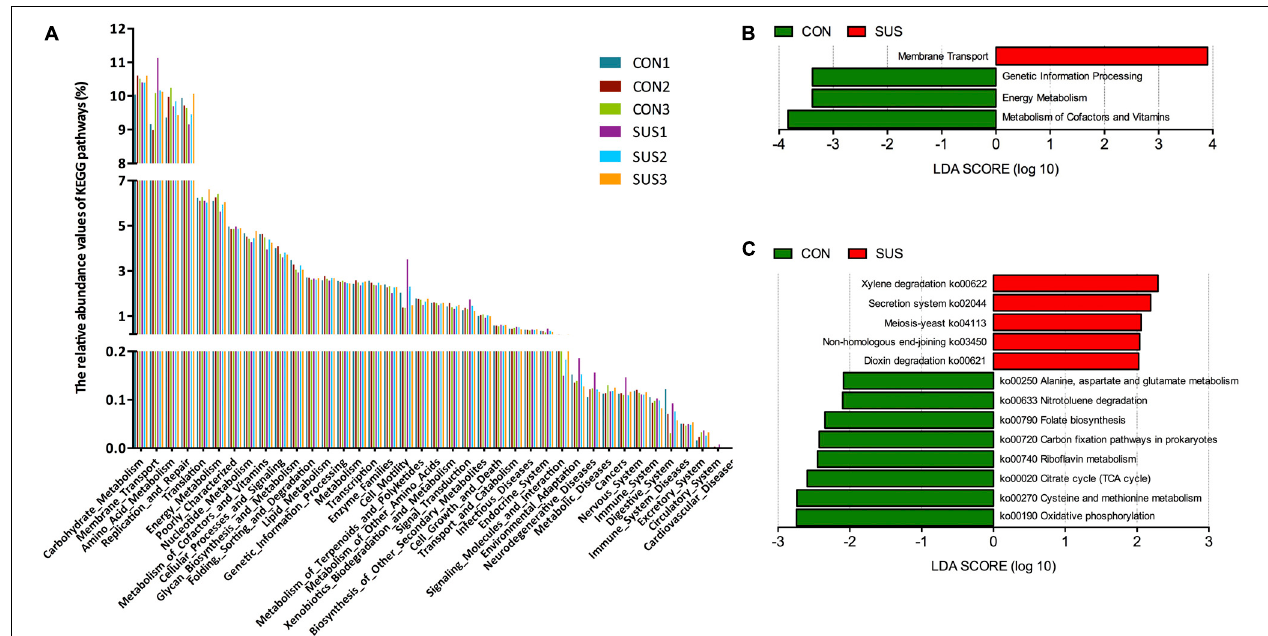
FIGURE 7 | Metagenomic functional predications associated to the microbiota profiles. (A) Relative abundance of the predicated gene of metagenome related to KEGG pathway at level 2. (B) and (C) Predicated genes of metagenome related to KEGG pathways and KEGG orthology differentially represented between two groups identified by LEfSe. CON, control group; SUS, simulated weightlessness